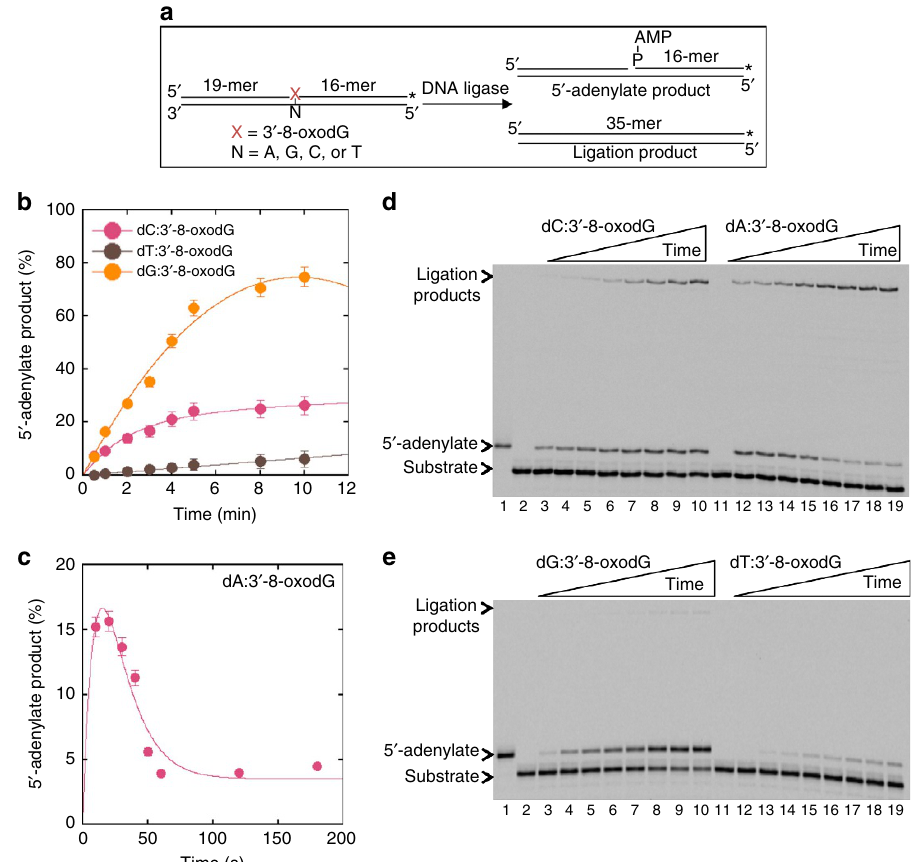
Figure 5 | Effect of 3’-8-oxoG on ligation. ( a ) Illustrations of nicked DNA substrate and reaction products for ligation and 5’-adenylation. Plots show time-dependent changes in the products of 5’-adenylation for the substrates C nick , G nick , T nick ( b ) and A nick ( c ). The data represent mean values with the s.d. from three independent experiments. ( d ) Lane 1 is the 5’-adenylated oligonucleotide used as a marker, lanes 2 and 11 are the minus enzyme controls for the substrates C nick and A nick , respectively. Lanes 3–10 and 12–19 are the reaction products, and correspond to time points of 0.5, 1, 2, 3, 4, 5, 8, 10min, and 10, 20, 30, 40, 50, 60, 120, 180s, respectively. ( e ) Lane 1 is the 5’-adenylated oligonucleotide used as a marker, lanes 2 and 11 are the minus enzyme controls for the substrates G nick and T nick , respectively. Lanes 3–10 and 12–19 are the reaction products, and correspond to time points of 0.5, 1, 2, 3, 4, 5, 8 and